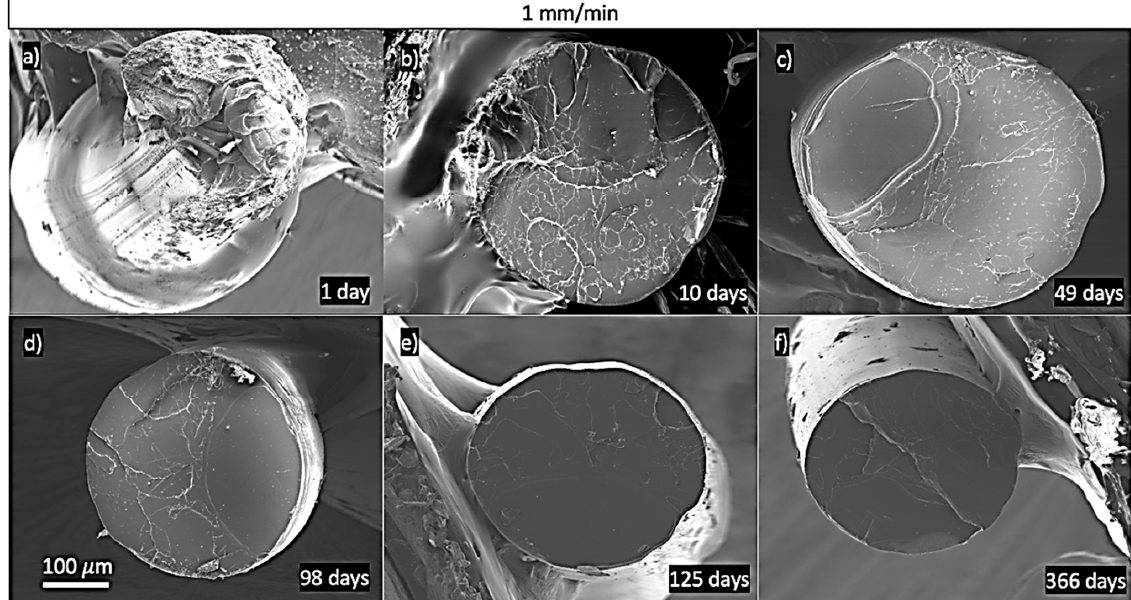
Figure 12. All samples tested at 1 mm/min ( ε = 5 × 10 − 1 min − 1 ) and extruded at 190 ◦ C. Transversal view of PLA at: ( a ) 1 day of ageing, ( b ) 10 days of ageing, ( c ) 49 days of ageing, ( d ) 98 days of ageing, ( e ) 125 days of ageing, and ( f ) 366 days of ageing.